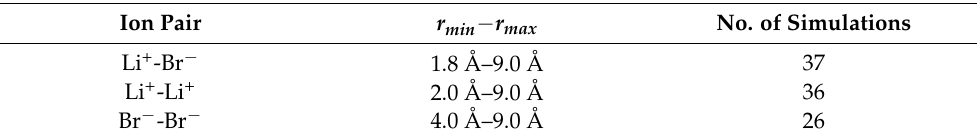
Table 2. Range of inter ion distances and total number of CMD simulations conducted for each ion